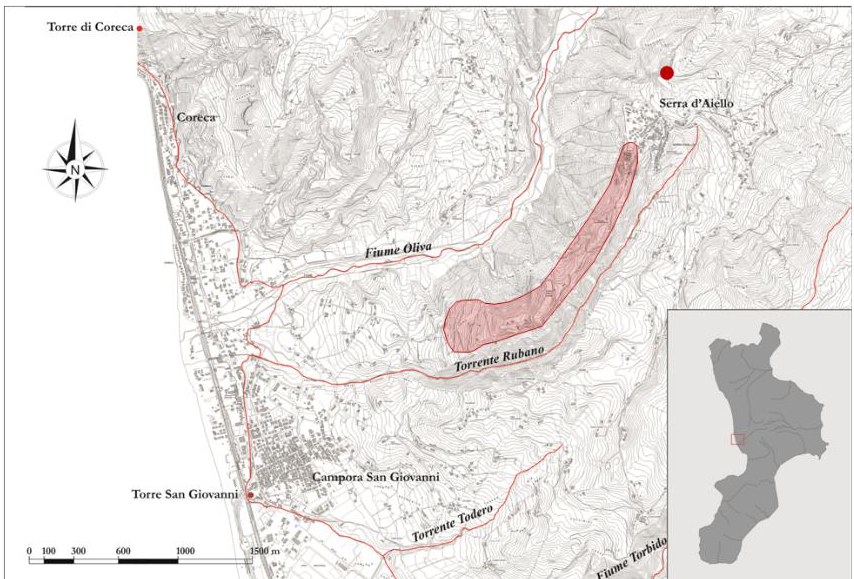
Figure 1. Map of the area between the rivers Oliva and Savuto: the pink shaded area indicates the protohistoric settlement, and the red dot indicates the location of rock sampling.